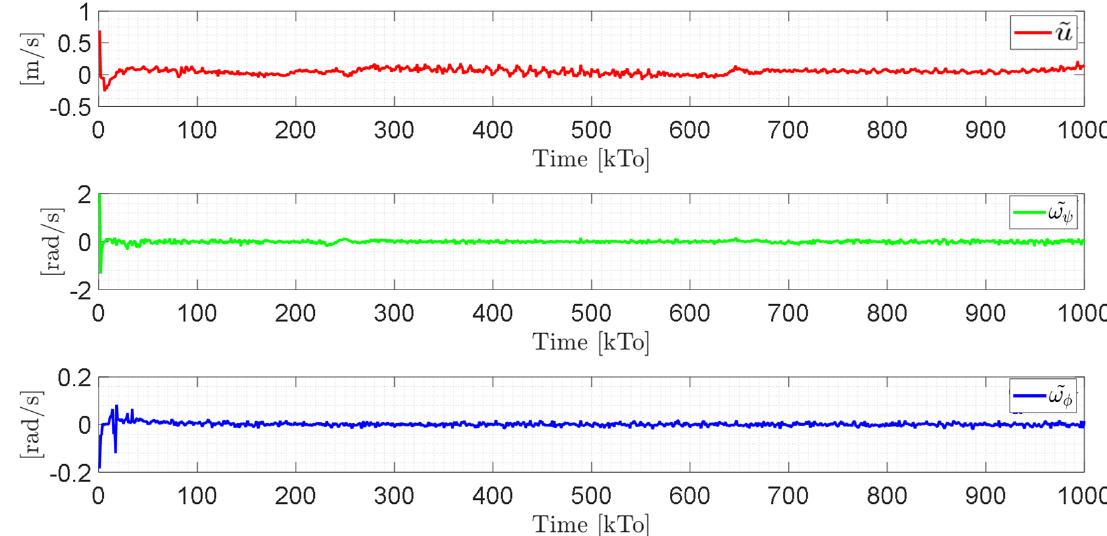
(cid:0) (cid:1) (cid:101) u , (cid:101) ω ψ , (cid:101) ω φ